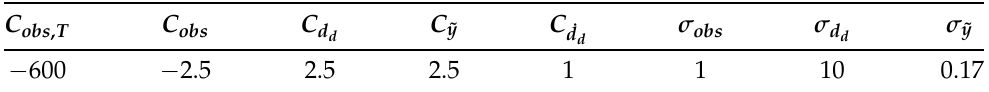
Table A1. Parameters used in the reward